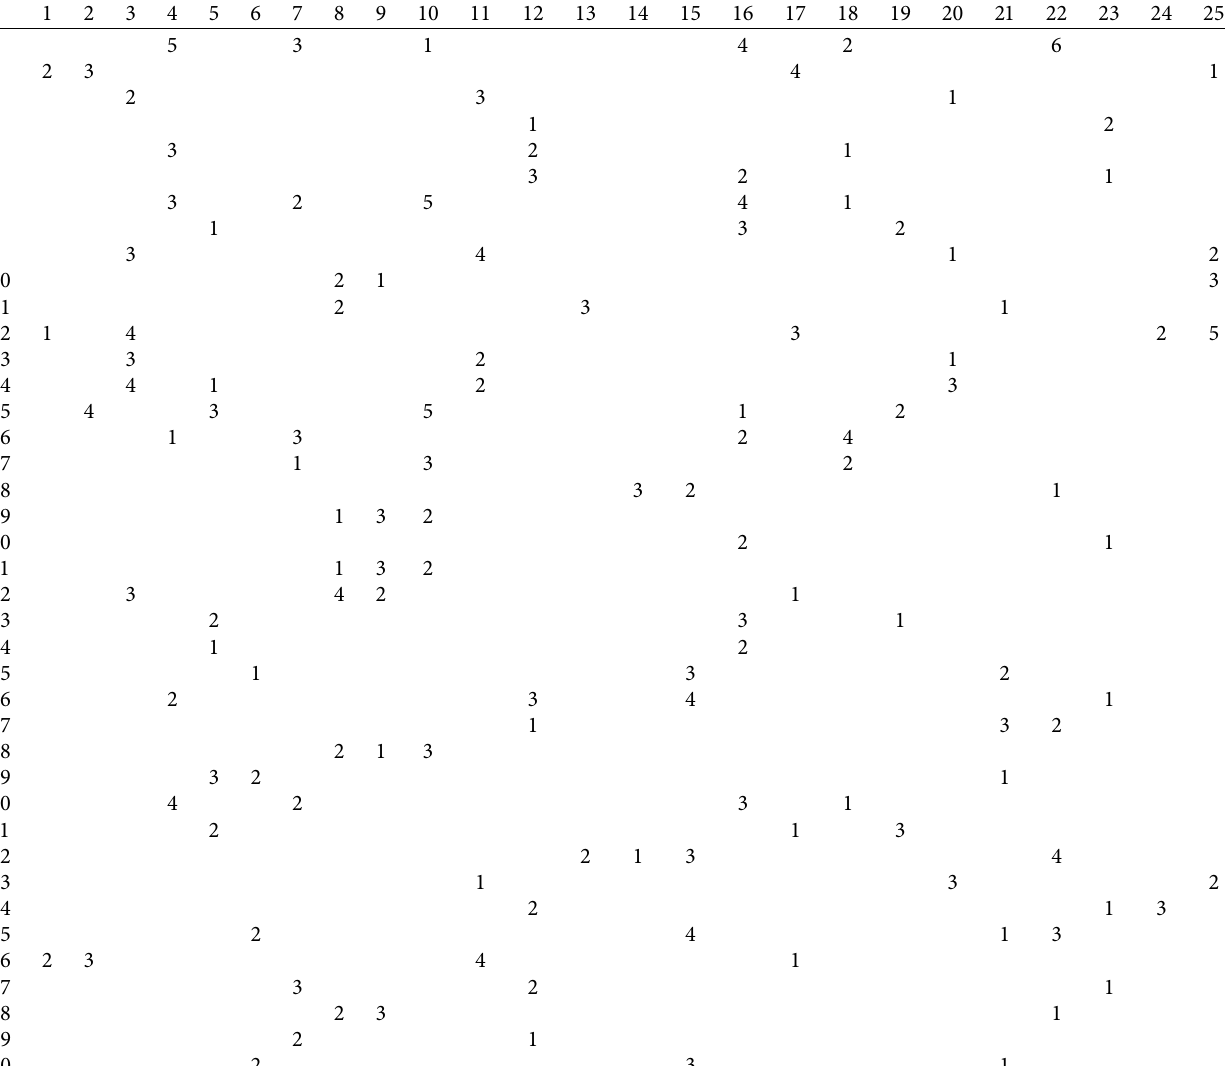
Table 2: Machine-component